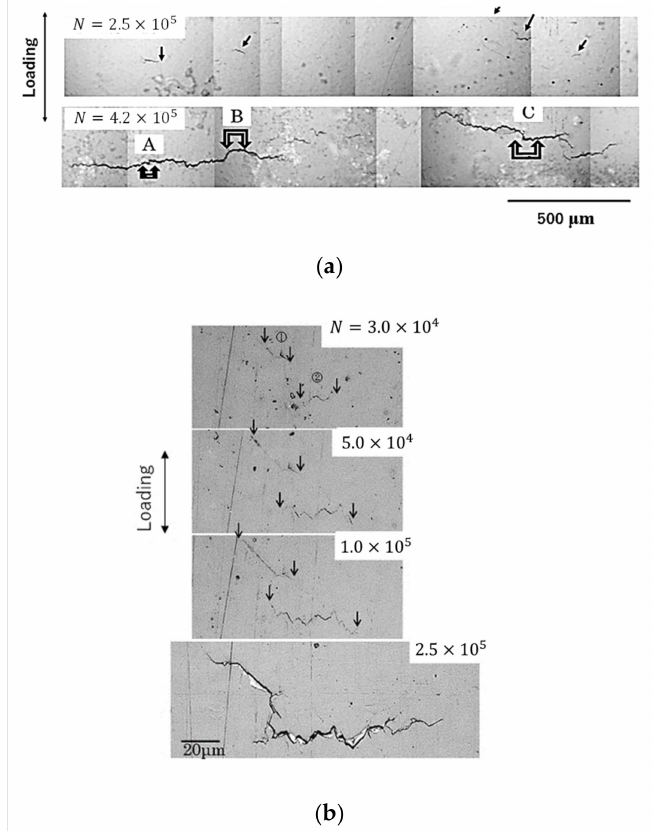
Figure 7. FCG behavior (Bi, A material, σ max = 350 MPa, R = 0.1) at different magnifications: ( a ) low and ( b ) high (crack C).